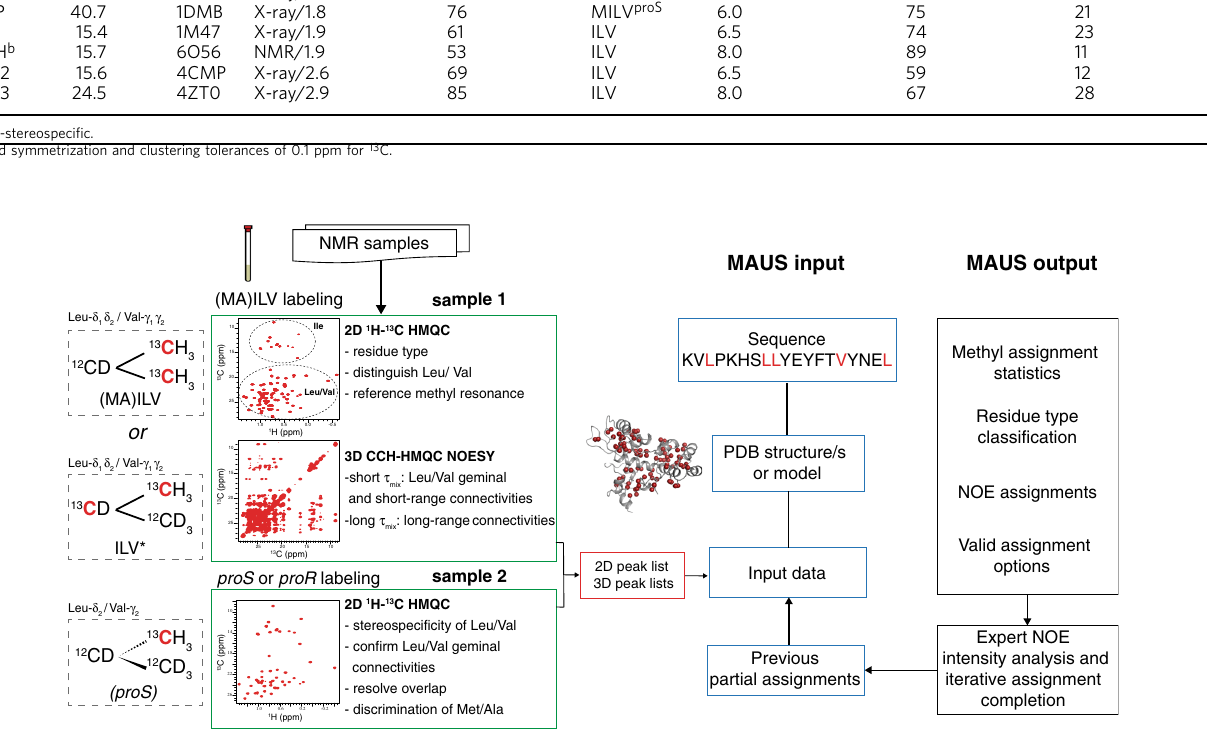
Fig. 2 Sample preparation, data collection, and methyl assignment work fl ow. Two separate protein samples are recommended for generating the standard inputs of MAUS. Sample 1 uses non-stereospeci fi c methyl labeling with either (i) 13 C/ 1 H labeling only at the methyls of Met, Ala, Leu, Val, and Ile residues, on a 12 C/ 2 H background or (ii) 13 C/ 1 H labeling at the methyls and 13 C/ 2 H at the sidechains of methyl-bearing residues on a 12 C/ 2 H background, creating linearized spin systems 43 , which can be used to unambiguously distinguish Leu/Val methyl resonances 18 (Supplementary Figs. 4 – 6). When sample i is used, resonances of Leu/Val peaks can be partially distinguished using an automated chemical shift-based classi fi er within MAUS ( “ Methods ” ). Both samples can be used to de fi ne reference methyl chemical shifts using real-time (sample i) or constant-time (sample ii) 2D